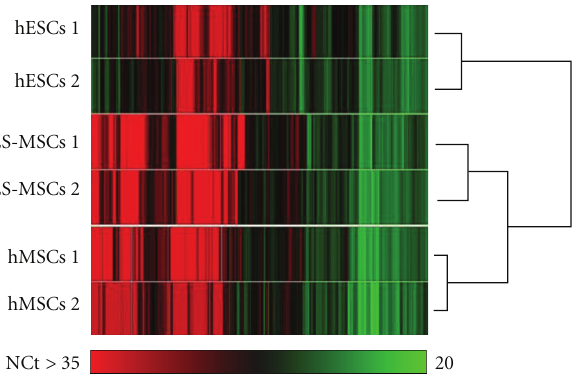
Figure 1: Hierarchical clustering of normalized Ct of 380 genes on hESCs, hES-MSCs, or hMSCs using individual samples and genes. Genes are classified using StatMiner Software and the Pearson test.